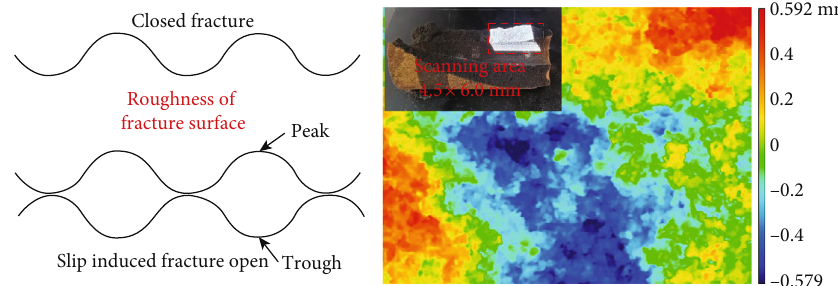
Figure 15: Roughness of C-T fracture surface.